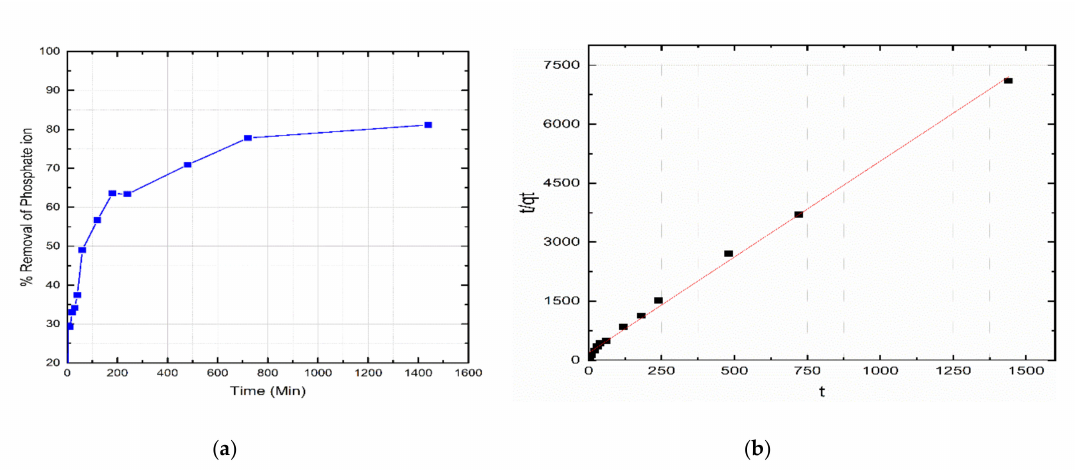
Figure 2. Kinetic of phosphate adsorption process: ( a ) E ff ect of contact time on phosphate removal and ( b ) linear regression of t / q vs. time (pseudo second-order).